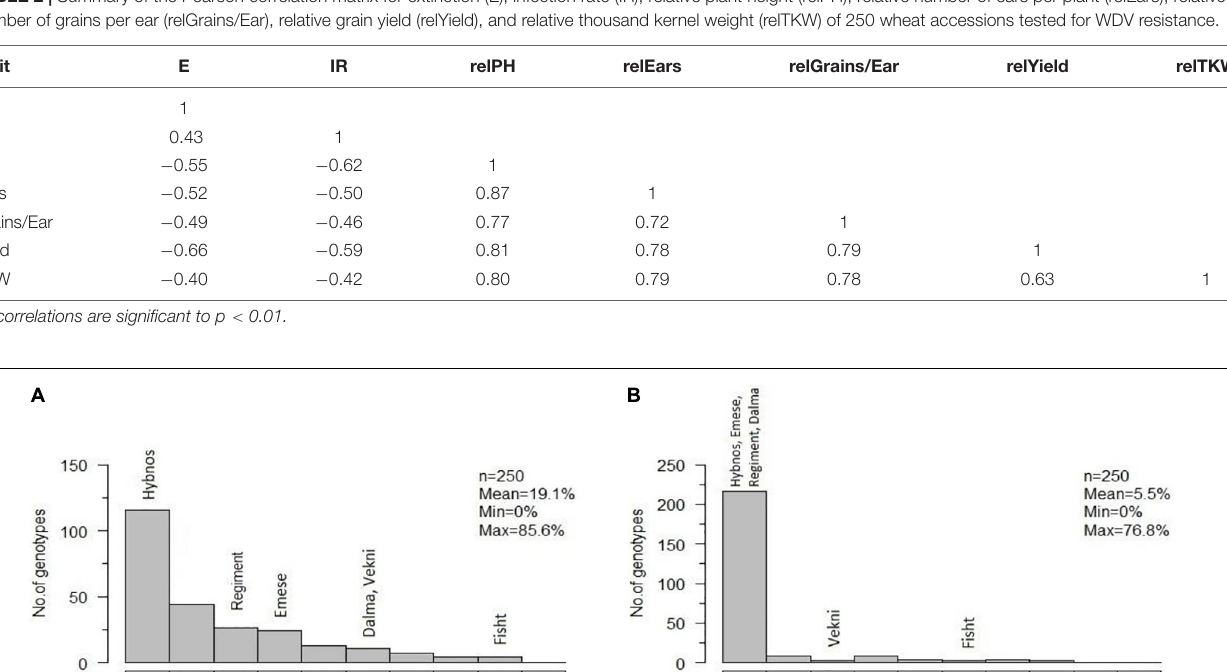
one T. macha , one Ae. geniculata , one Ae. bicornis,